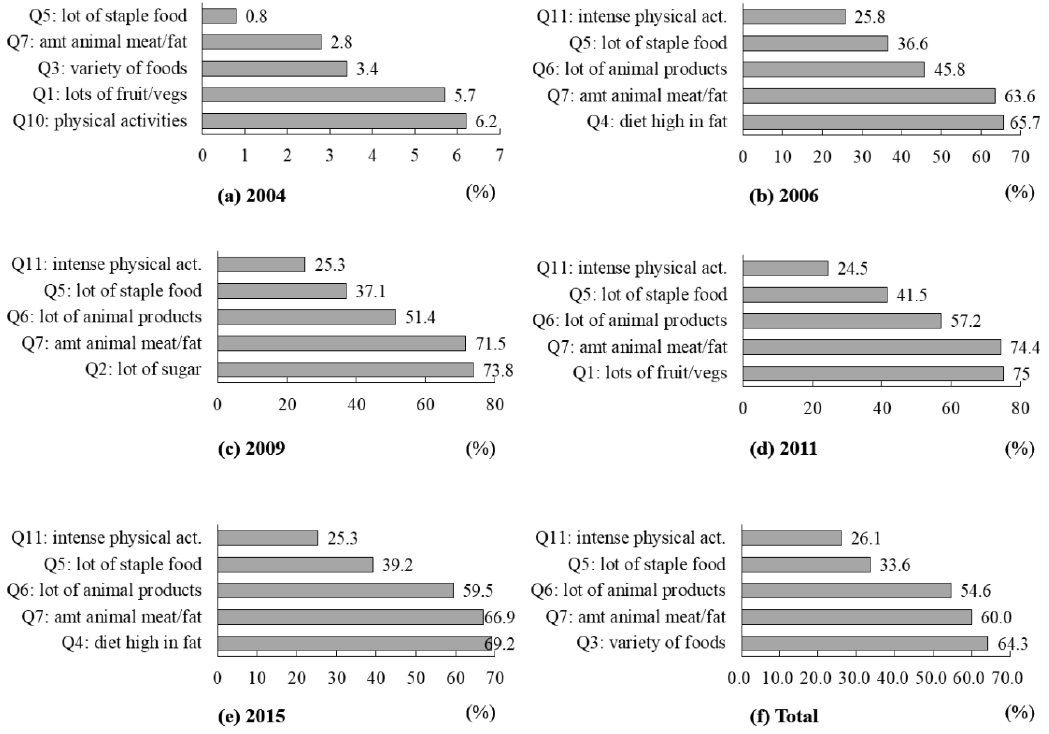
Figure 2. Top five dietary knowledge items with the lowest correct rate in 2004–2015. Table 3. The dietary knowledge literacy of participants with di ff erent demographic characteristics in